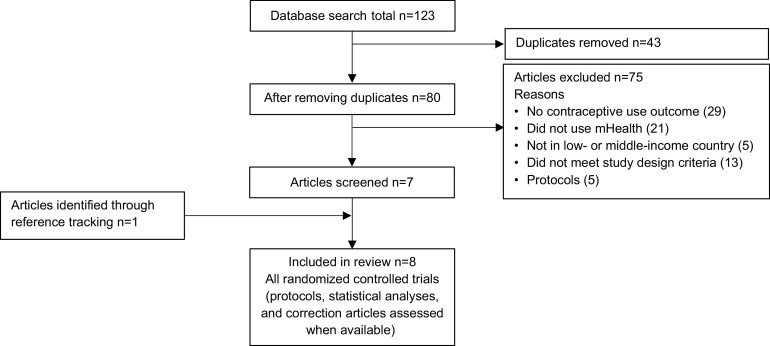
PRISMA Flow Diagram for the Systematic Review of Experimental Studies Evaluating the Effectiveness of mHealth Interventions on Contraceptive Uptake in Low- and Middle-Income CountriesAbbreviation: PRISMA, Preferred Reporting Items for Systematic Reviews and Meta-Analyses-Protocols.